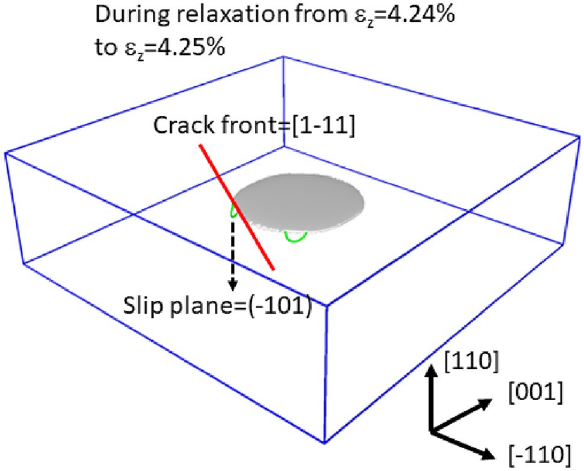
Figure 6. Snapshot depicting the situation immediately after dislocation emission from the crack along {110}; the gray part denotes the cracked surfaces, and the green lines are 1/2<111> dislocations; the red straight line indicates the crack front direction from which a 1/2<111> dislocation is